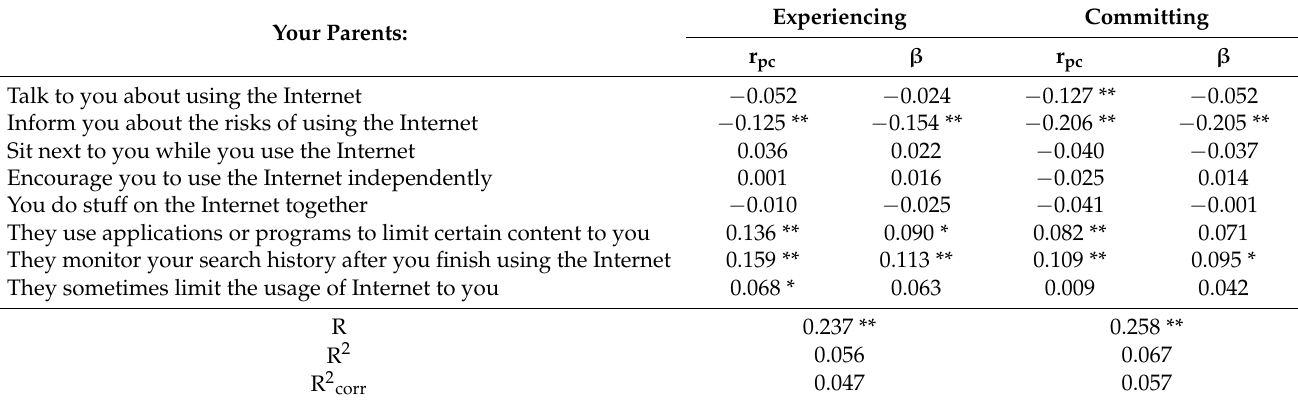
Table 4. The standardized parameters and regression results for the prediction of experiencing and committing violence by parental monitoring